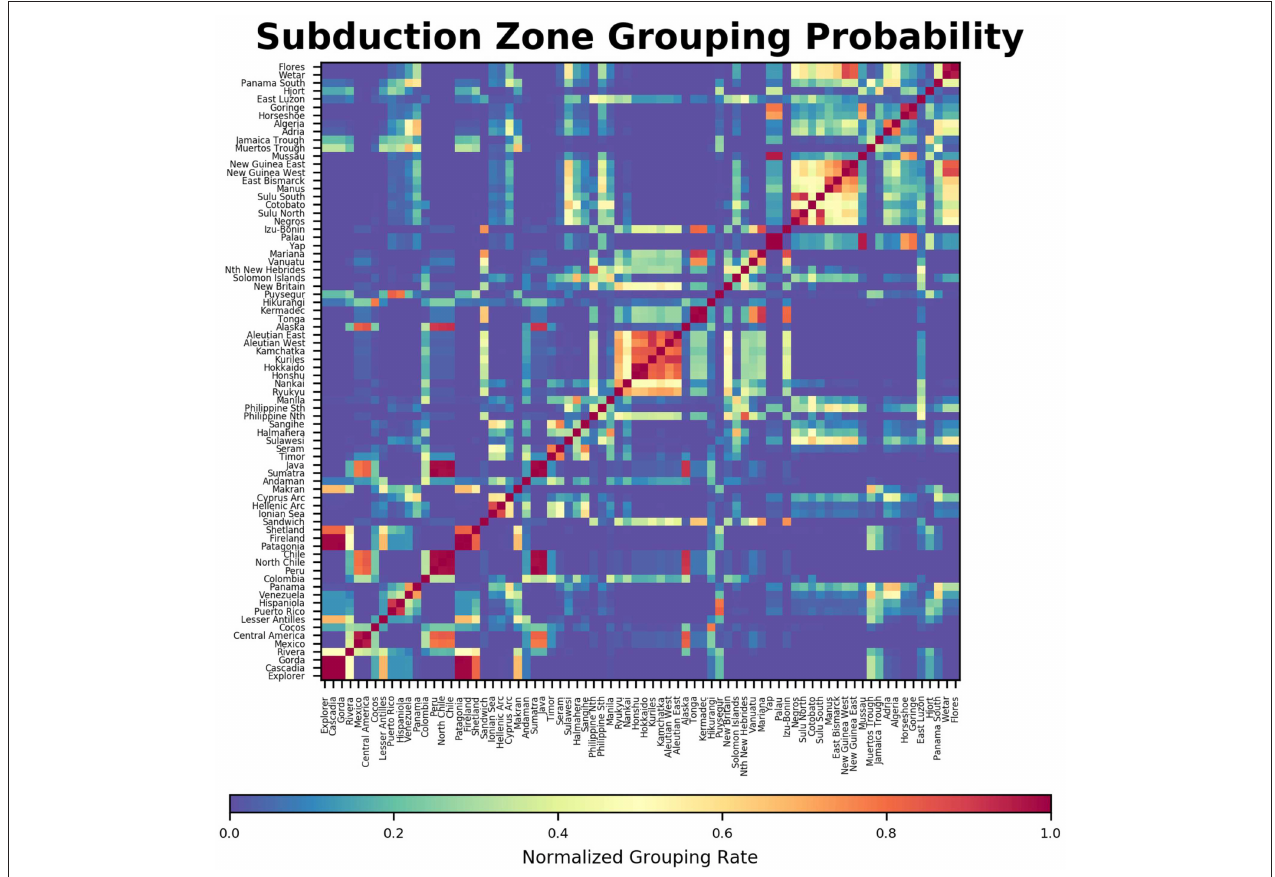
FIGURE 4 | Probability of subduction zone mating, where 1 (red): subduction zones always group within the same class and 0 (blue): subduction zones never same the share